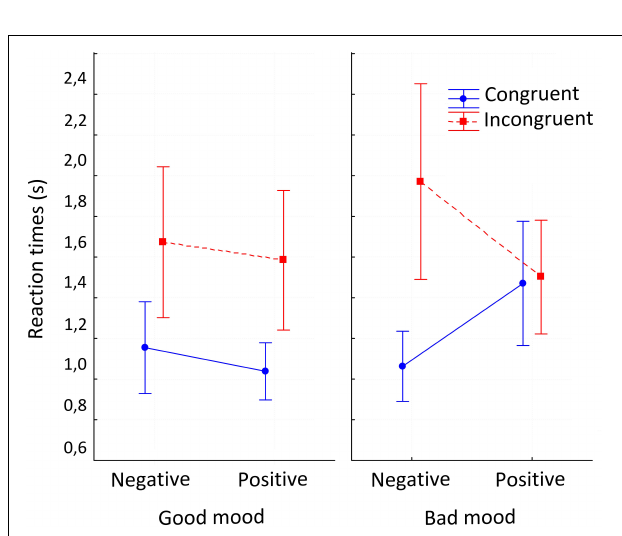
FIGURE 4 | Interaction between the three factors. Interaction effect in repeated measure ANOVA between congruency, emoticon’s valence and mood detection factors. Vertical bars denote 0.95 confidence